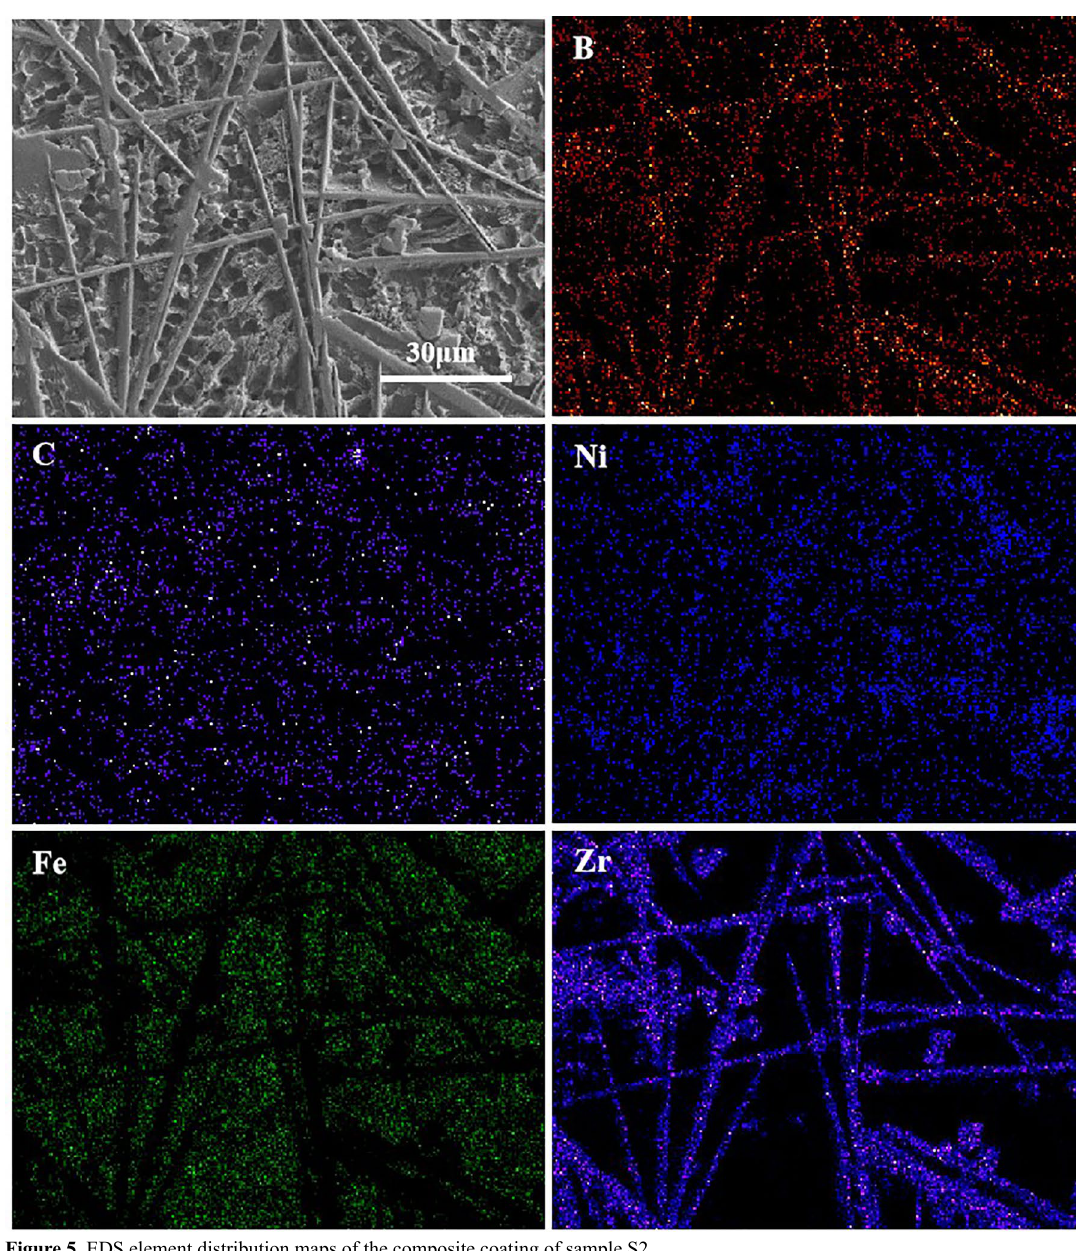
Figure 5. EDS element distribution maps of the composite coating of sample S2. there are two types of ZrB grains formed in the Zr-B C 2 4 system coating from the top to the bottom. In general, ZrB 2 grains are mainly slender acicular structure on the top of the composite coating and tend to be short clubbed structure at the bottom. The ratio of length and width for ZrB particles 2 decrease significantly, which is similar to the previous study 14